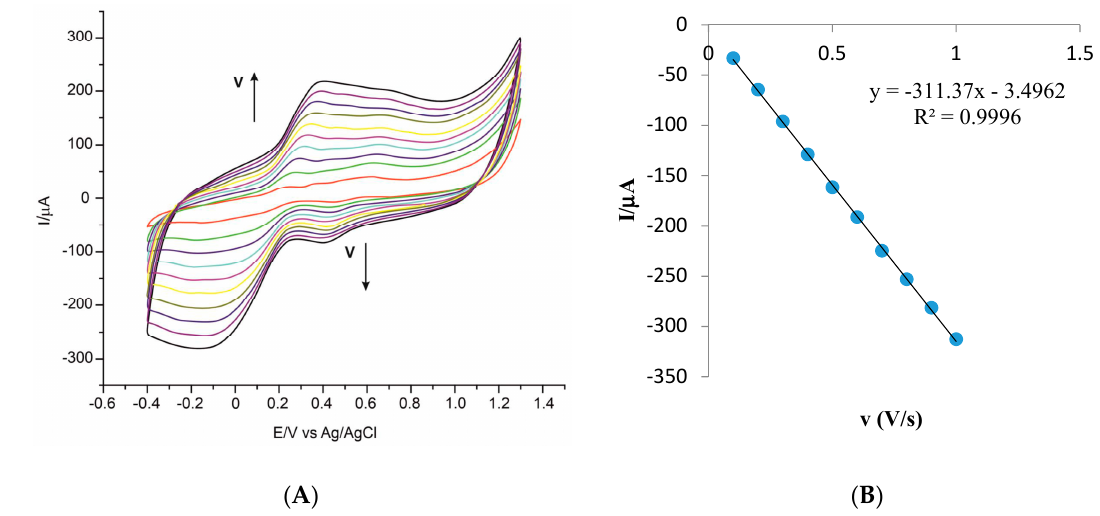
Figure 4. ( A ) Cyclic voltammograms of CNF-GNP-Ty/SPE in 10 − 3 M ferulic acid–10 − 1 M PBS solution (pH 7.0). The cyclic voltammograms with different colors correspond to different scan rates. ( B ) The plot of cathodic peak currents (i c ) vs. scan rates.